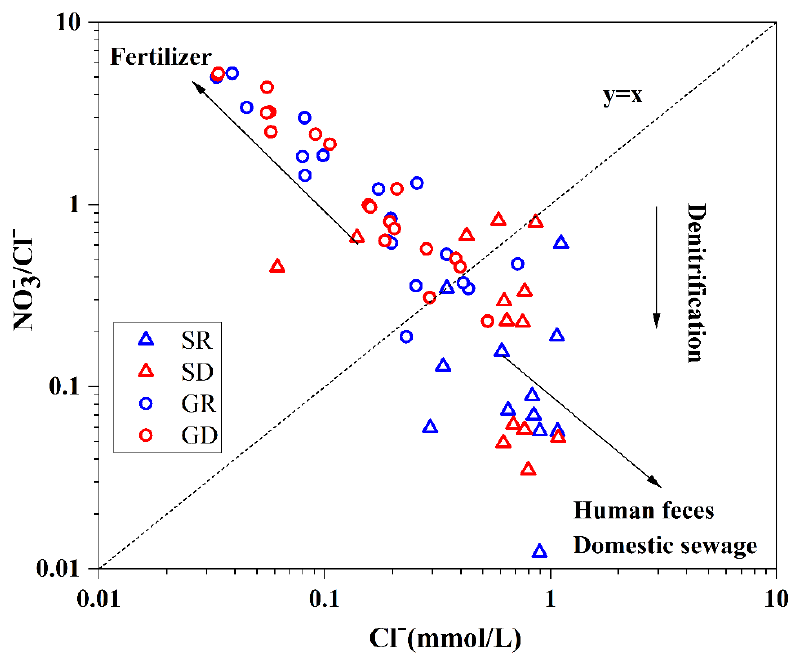
/Cl − . Figure 10. Relationship between Cl − and NO − /Cl − 3 3